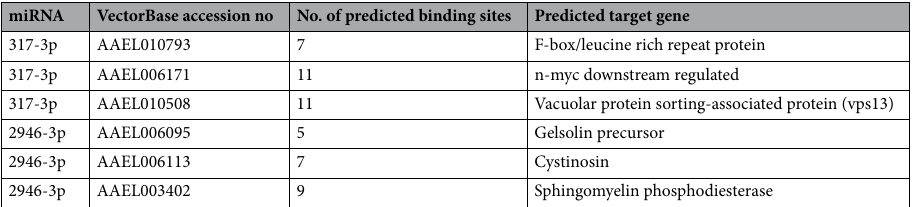
Table 3. High confidence predicted targets of aae-miR-317-3p, and aae-miR-2946-3p. These predicted targets were subjected to RT-qPCR to determine if their expression could be affected by age (Fig. 6).